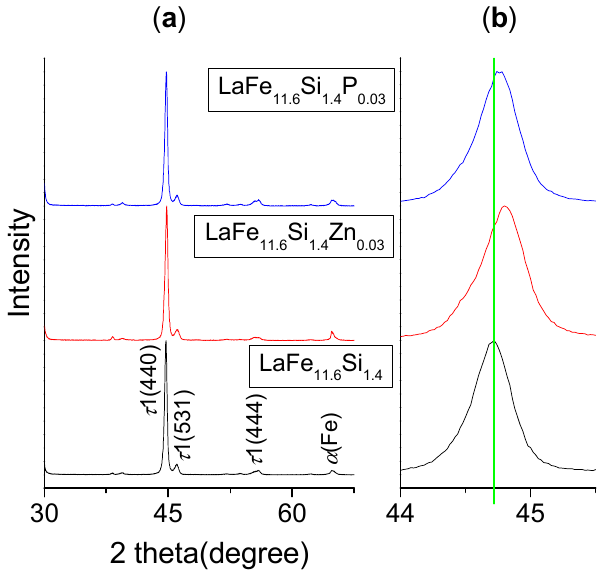
Figure 4. X-ray diffraction (XRD) patterns of the annealed LaFe 11.6 Si 1.4 , LaFe 11.6 Si 1.4 Zn 0.03 , and LaFe 11.6 Si 1.4 P 0.03 plates at room temperature ( a ), and ( b ) enlarged τ 1 (440) peak showing the shift towards higher angle regime with Zn/P alloying.